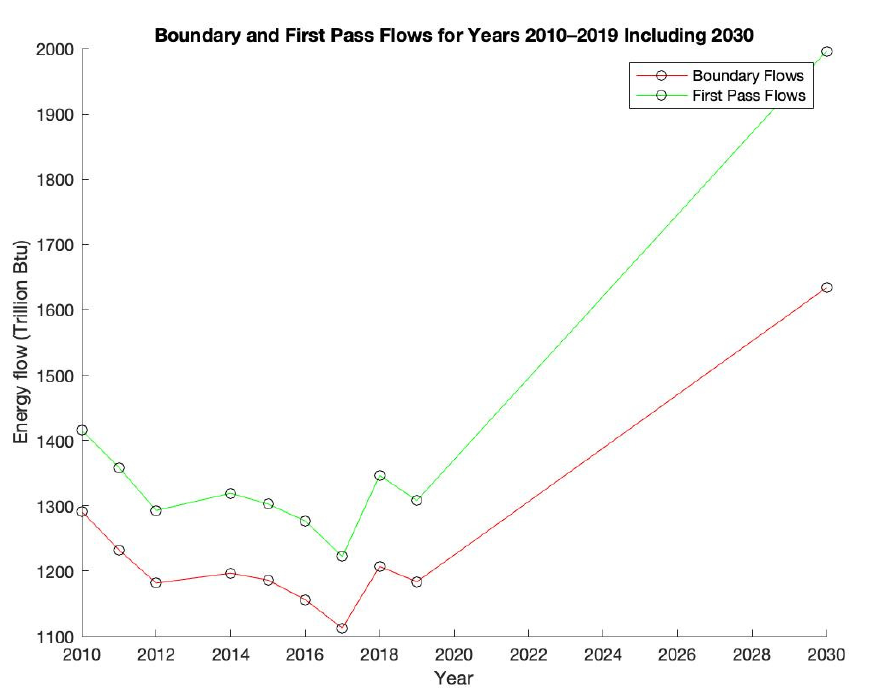
Figure Figure 9. Boundary and first pass flows for Maryland’s energy industry from 2010–2019 including 2030.